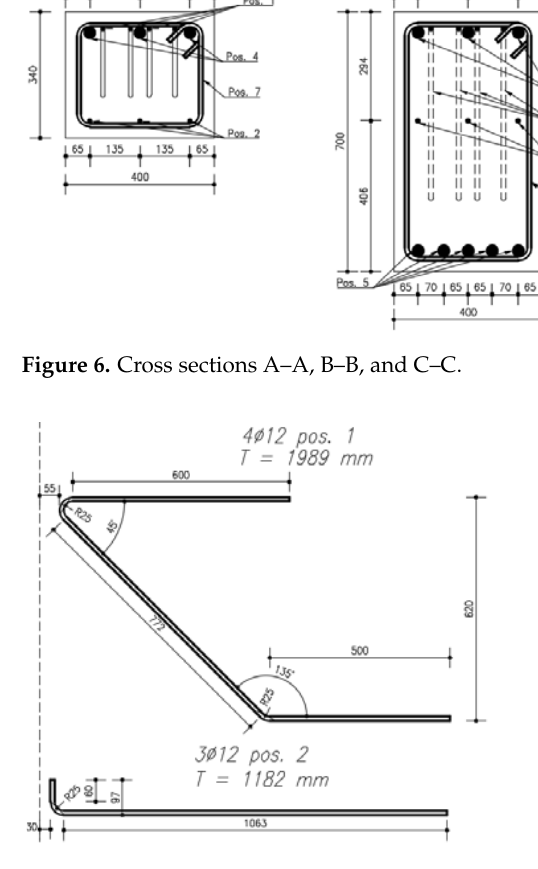
Figure 7. Rebars in pos. 1 and pos.